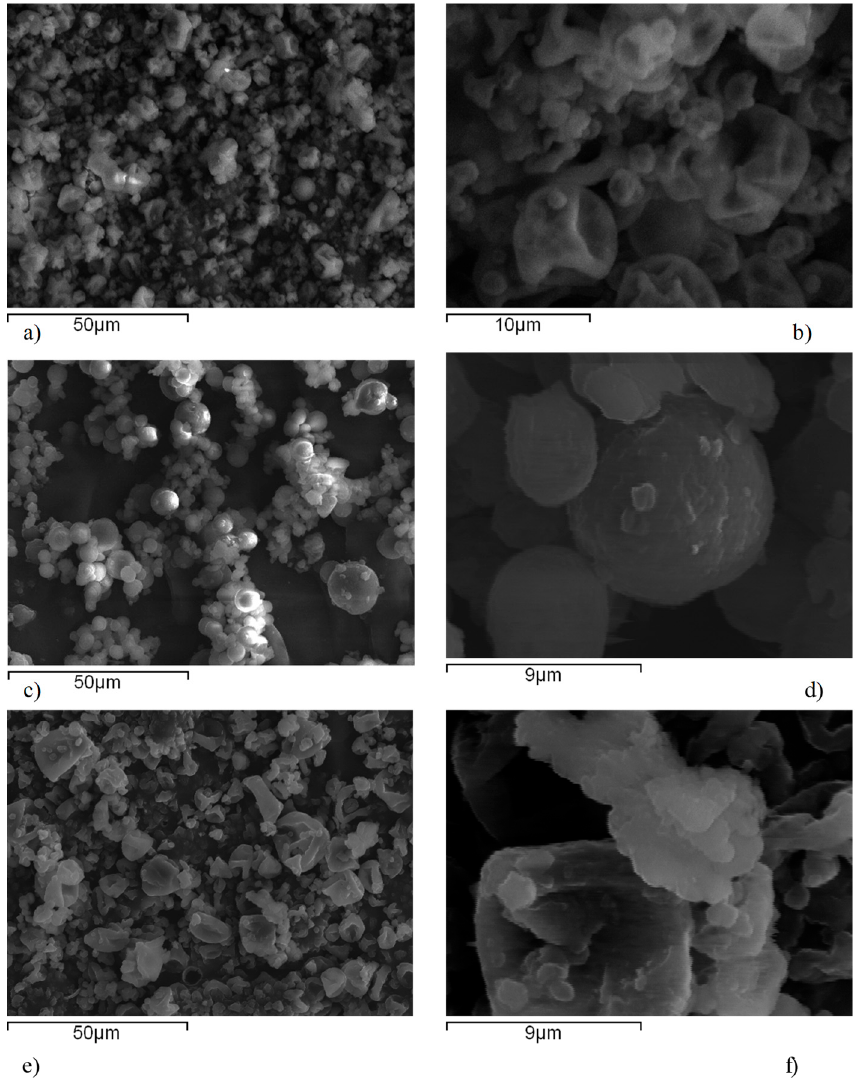
Figure 9. SEM photomicrographs of spray dried glimepiride nanosuspensions: ( a , b ) F1 (HPC-SL), ( c , d ) F2 (poloxamer 188), and ( e , f ) F3 (Pharmacoat ® 603).